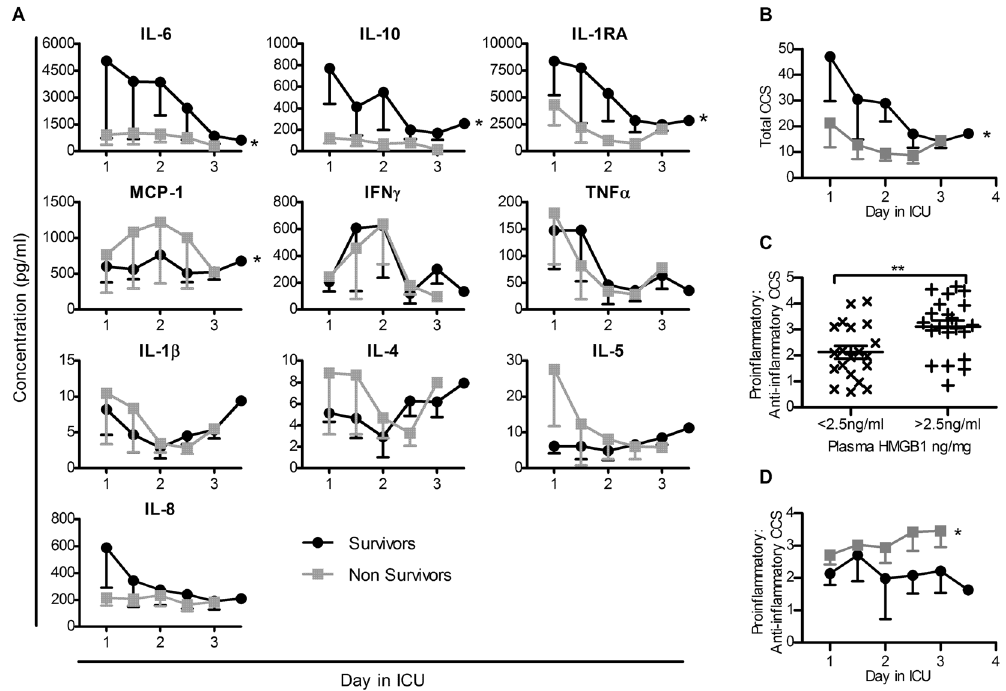
Figure 2. Mortality and elevated HMGB1 are associated with a proinflammatory serum cytokine profile in a cohort of septic shock patients. Plasma samples from septic shock patients were stored and analysed via multiplex analysis. A panel of cytokines (IL-6, MCP-1, IL-10, IFN γ , TNF α , IL-1 β , IL-4, IL-5, IL-8 and IL- 1RA) was assessed and concentrations calculated from samples run in duplicate. ( A ) Plasma concentrations of individual cytokines between survivors (black) and non-survivors (grey) were compared via paired t-test. Cytokine measurements normalised to the median concentration were used to determine composite cytokine scores (CCS). ( B ) Total CCS indicating the total magnitude of cytokine levels was calculated by summation of all ten normalised cytokine scores and compared between survivors and non-survivors. The ratio of pro- inflammatory (IL-6, MCP-1, IFN γ , TNF α , IL-1 β , IL-5 and IL-8) to anti-inflammatory (IL-10, IL-4 and IL-1RA) signalling was compared between samples with a low and high HMGB1 content ( C ) and between survivors and non-survivors ( D ). Plasma cytokine concentrations and ratio between survivors and non-survivors were compared via paired t-test and low vs high HMGB1 content samples were compared via unpaired t-test. Data are depicted as mean ± SEM, with significance is denoted as thus: * P < 0.05, ** P <